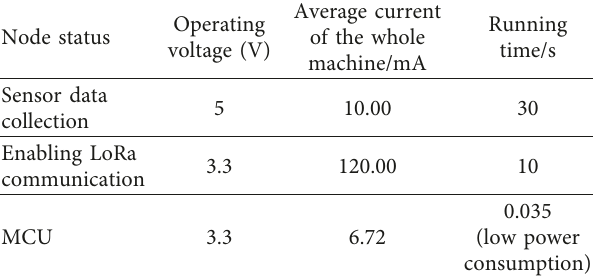
Figure 9: Main parameter setting interface of the device. Table 4: Basic parameters of LoRa terminal